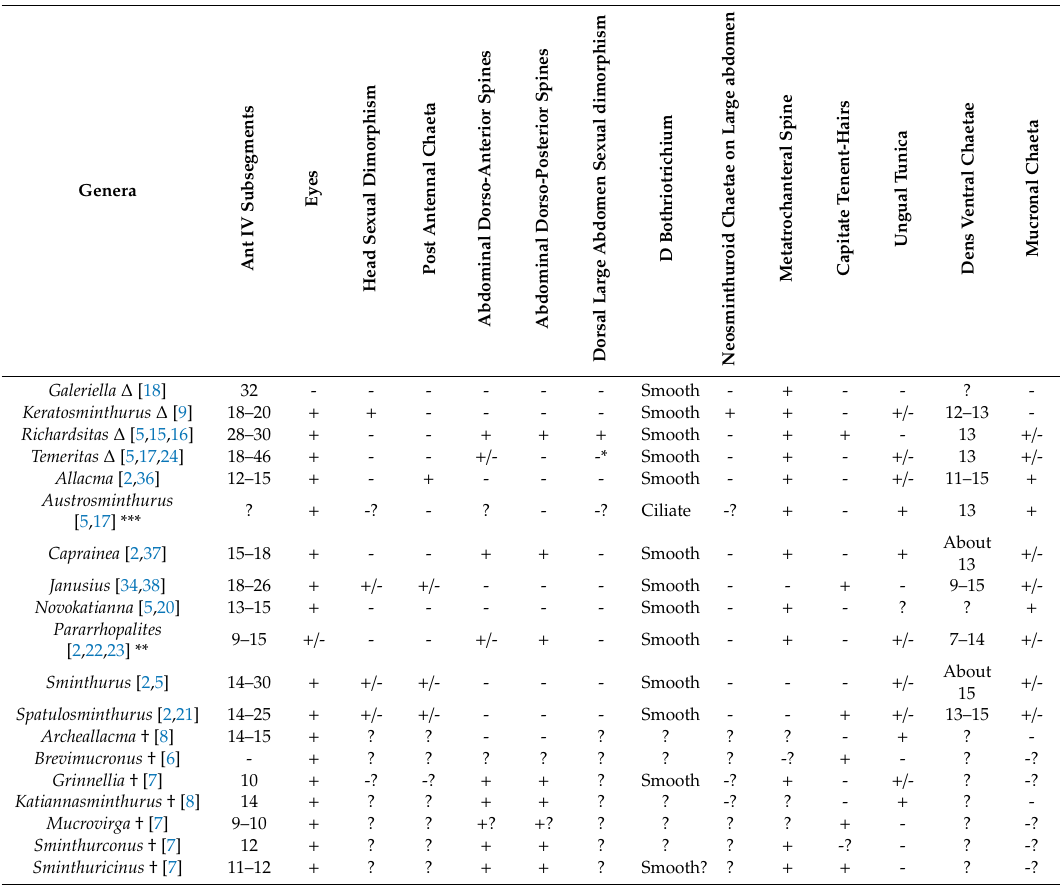
Table 2. Main diagnostic characters of Sminthurinae genera sensu Bellinger et al. 1996–2020.